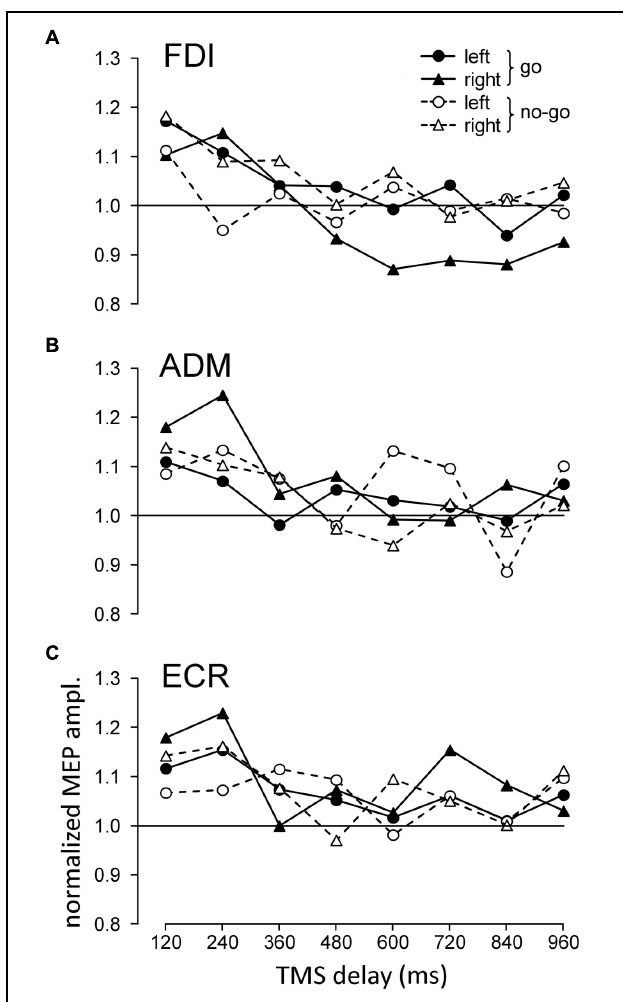
FIGURE 3 | Graphs depicting the time course of the changes in the mean normalized motor evoked potential (MEP) amplitudes with respect to stimulus onset, recorded from the first dorsal interosseous (FDI) (A), ADM (B), and ECR (C) muscles as a function of cue side and ocular task (‘go’/‘no-go’). Values higher than unity indicate MEP amplitudes larger than baseline.